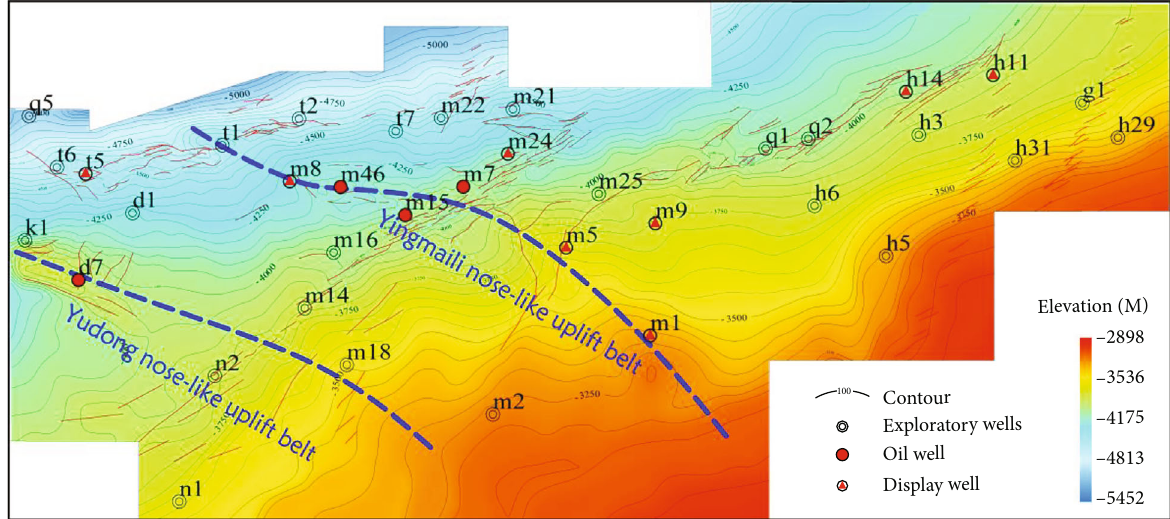
Figure 15: The current structure of the base of Cretaceous in the western Tabei area.